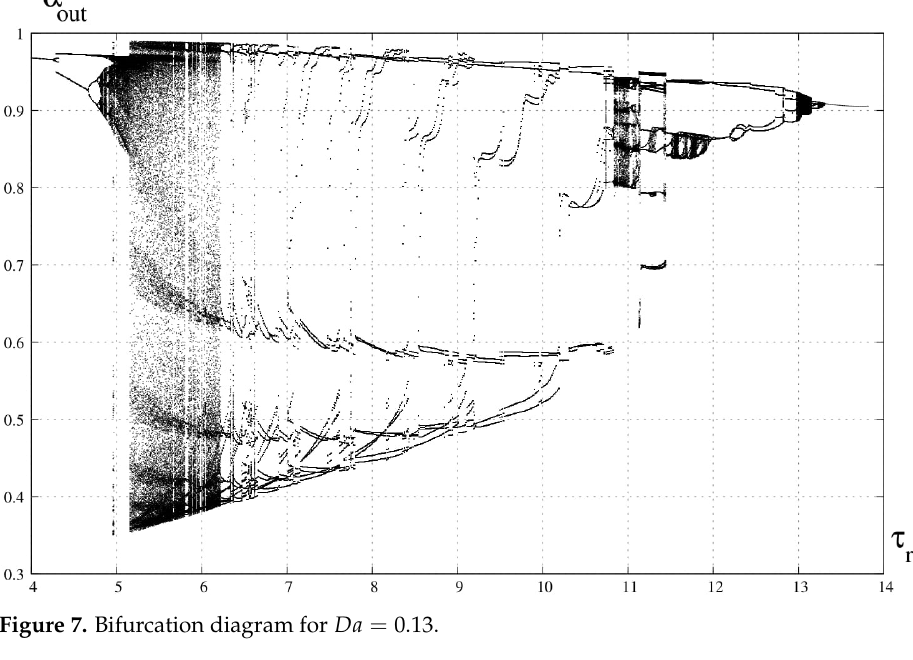
Figure 7. Bifurcation diagram for Da = 0.13.